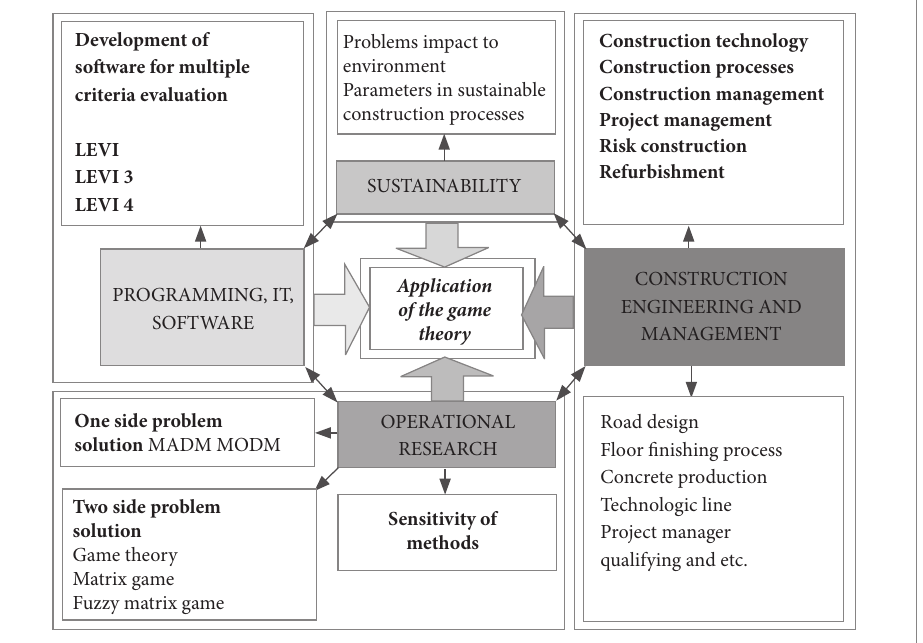
Fig. 3. Applications of game theory over 42 years of Professor Friedel Peldschus’ research